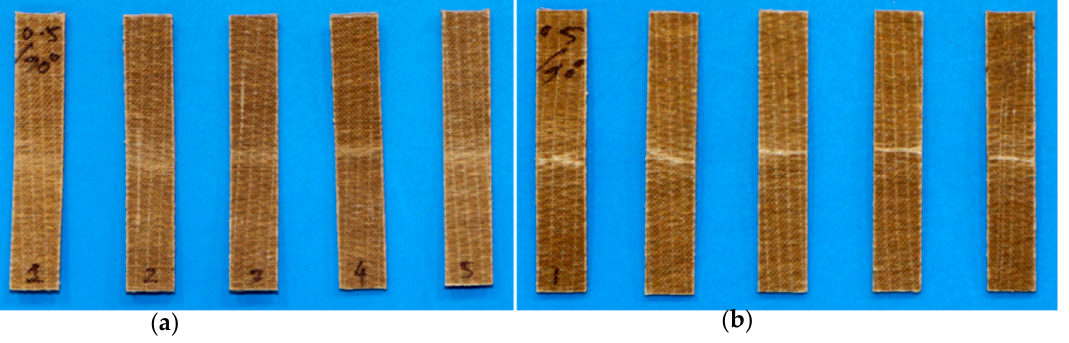
Figure 23. Typical flexural fracture samples: ( a ) Side of the applied load and ( b ) opposite side of the applied load.